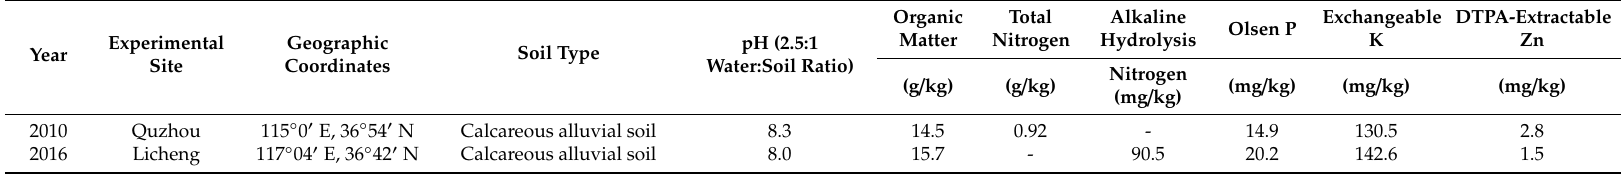
Table 1. Detailed site locations (geographic coordinates) and soil basal properties in 0–20 cm soil layers before maize